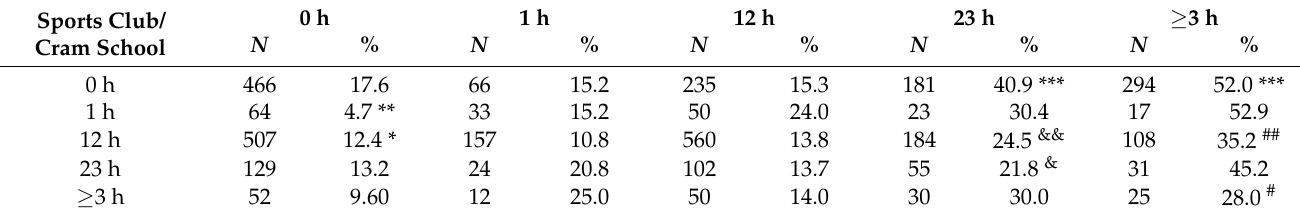
Table 5. Relationship between the time spent attending one sports club and/or cram school session and the rate of wearing glasses. Sports